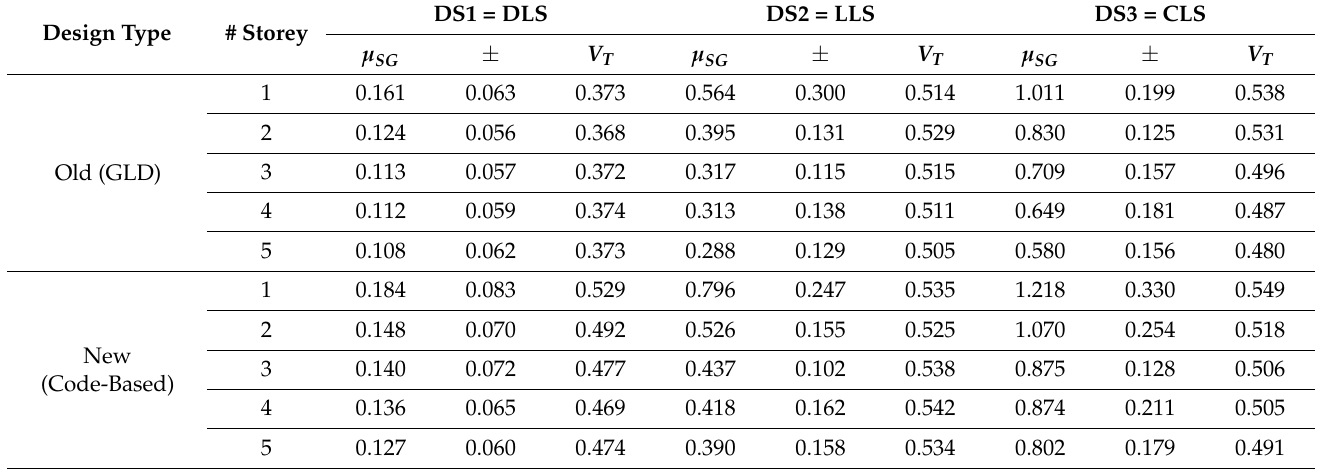
Table 7. Fragility curve parameters including soil type and demand variability (mean µ SG , fuse width around the mean, and total coefficient of variation V T ), for three Damage/Limit States, two construction types (“Old”, Gravity Load Design, and “New”, code-based design) and with number of storeys ranging from 1 to